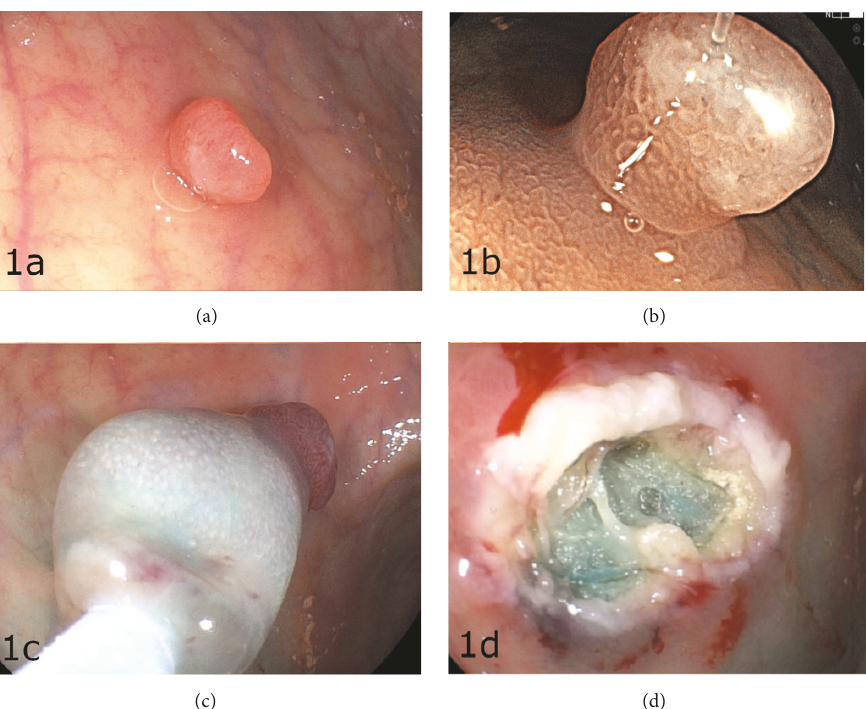
Figure 1: Endoscopic findings. (a) Endoscopic appearance of the sessile gastric HP. (b) Magnifying endoscopy with FICE of the polyp. (c) EMR with lateral safety margins. (d) Endoscopic finding after en bloc resection.